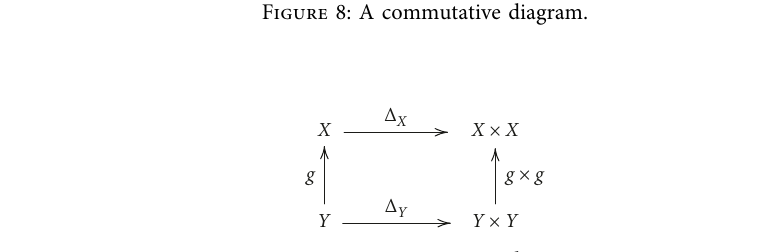
Figure 8: A commutative diagram.